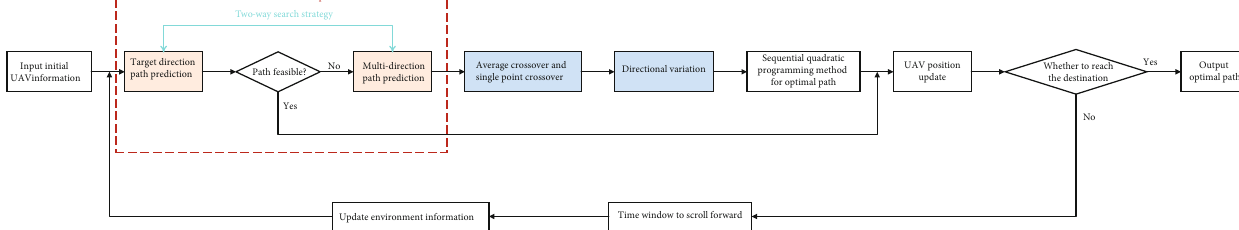
Figure 1: Receding horizon control with extended solution for UAV path